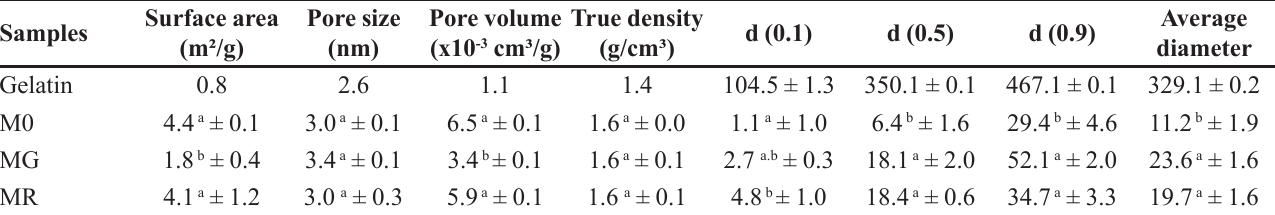
Different letters in the same column represent statistically different results according to the ANOVA followed by Tukey test. M0: uncrosslinked gelatin microspheres; MG: gelatin microspheres crosslinked with GTA; MR: gelatin microspheres crosslinked with